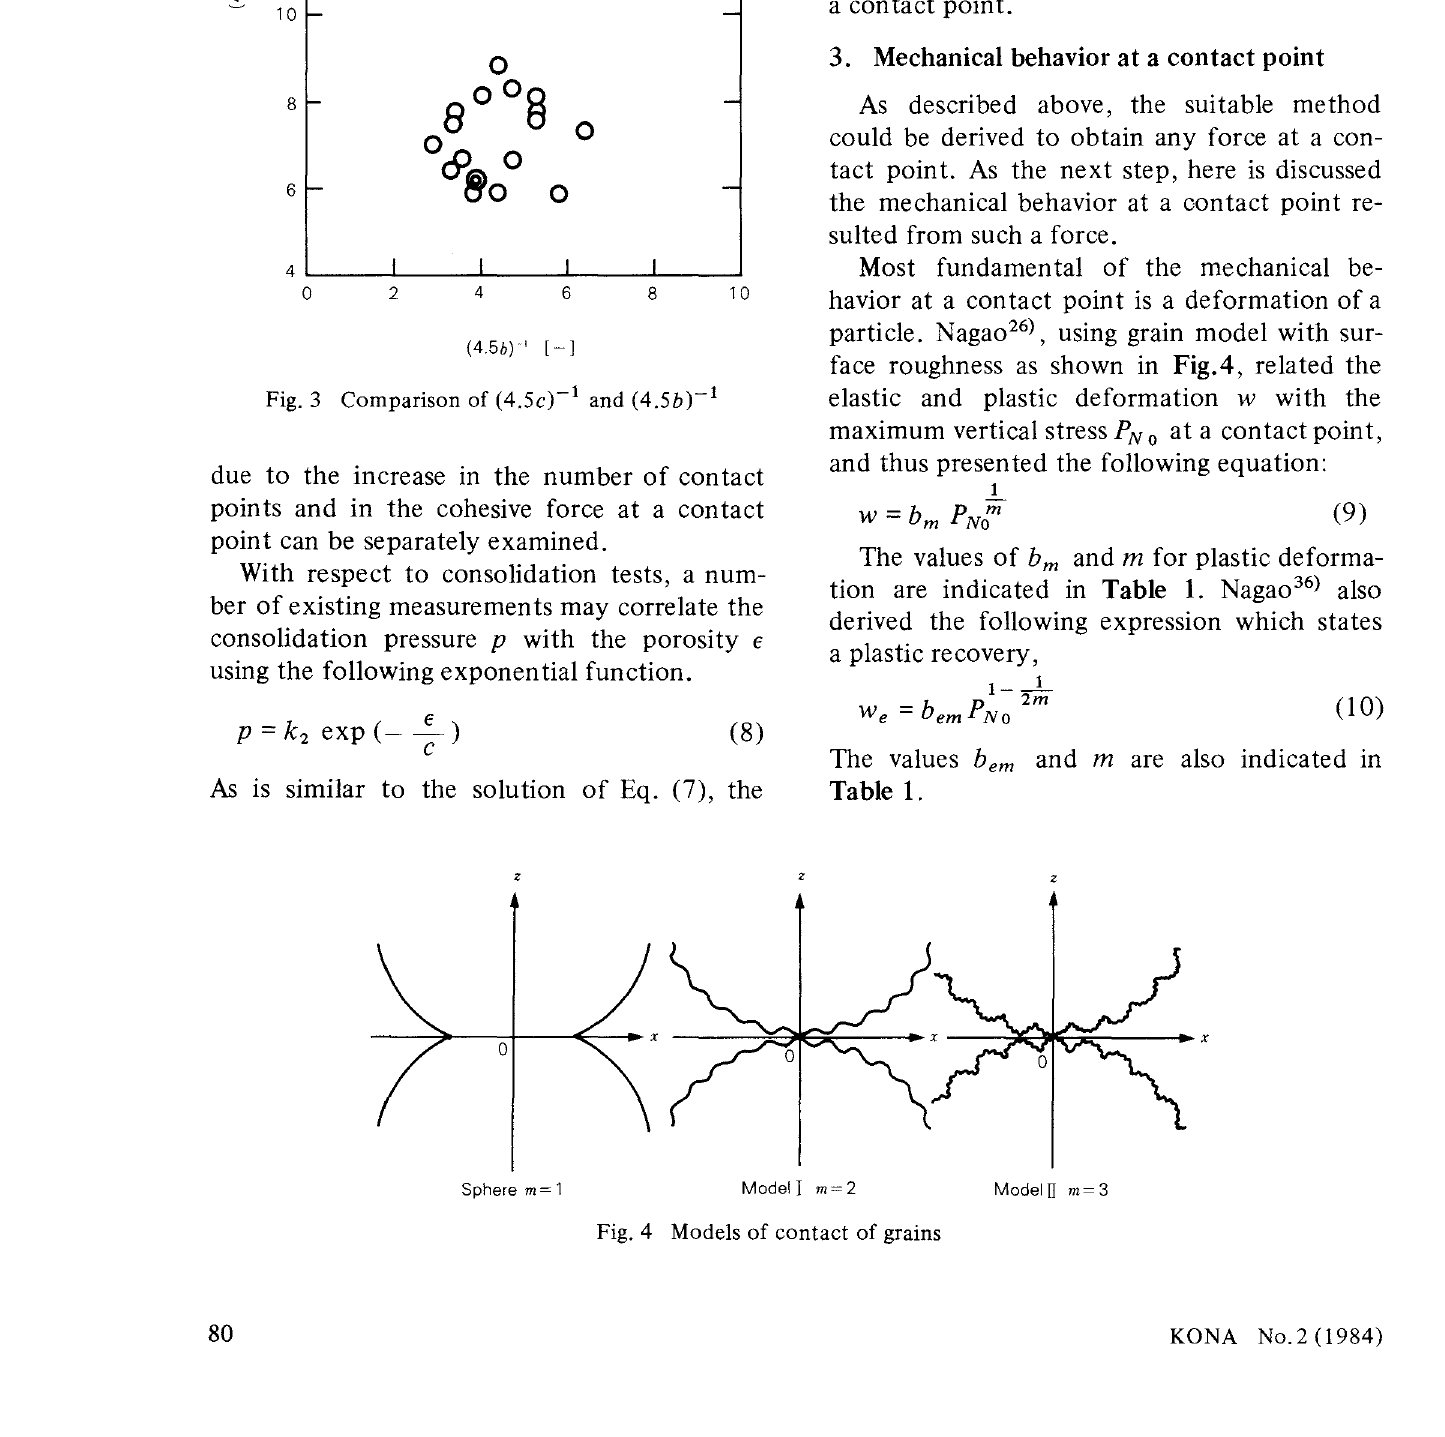
Fig. 4 Models of contact of